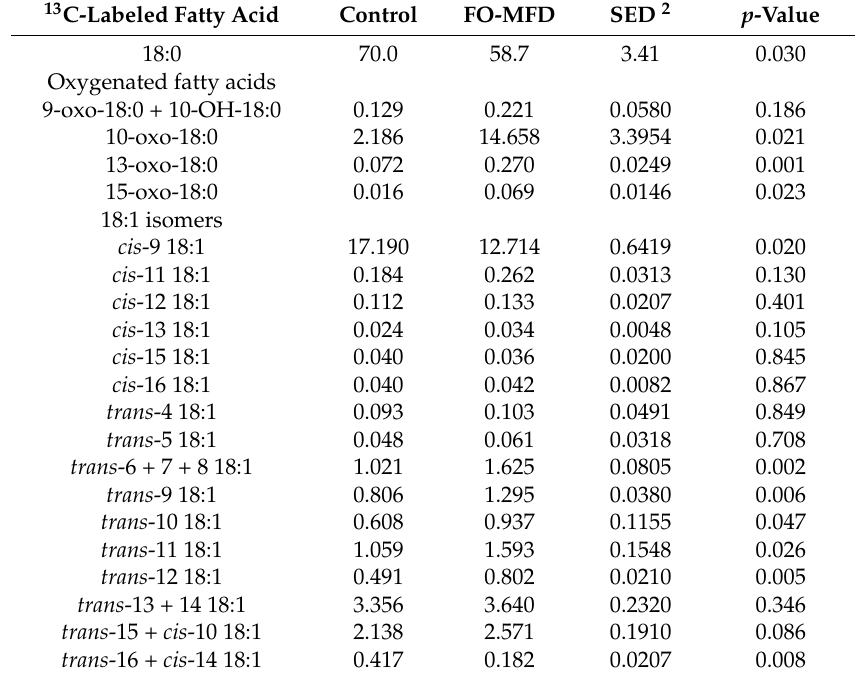
Table 2. Effects of rumen inoculum (control vs. FO-MFD 1 ) on the proportion of 13 C-labeled fatty acids in digesta (expressed as % of incubated 13 C oleic acid) after 24 h of in vitro incubation. 13 C-Labeled Fatty